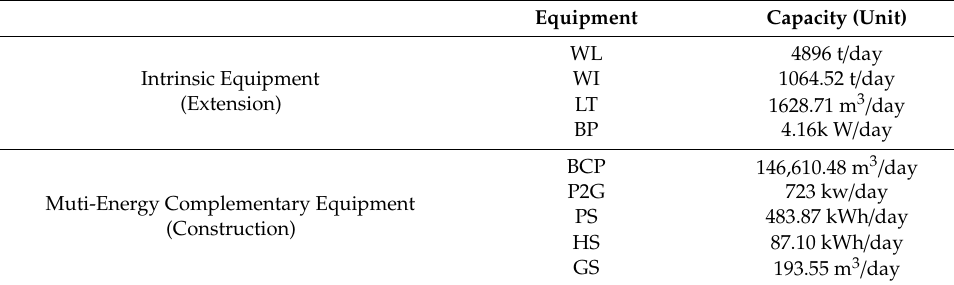
Table 3. The information of the multi-energy complementary equipment.